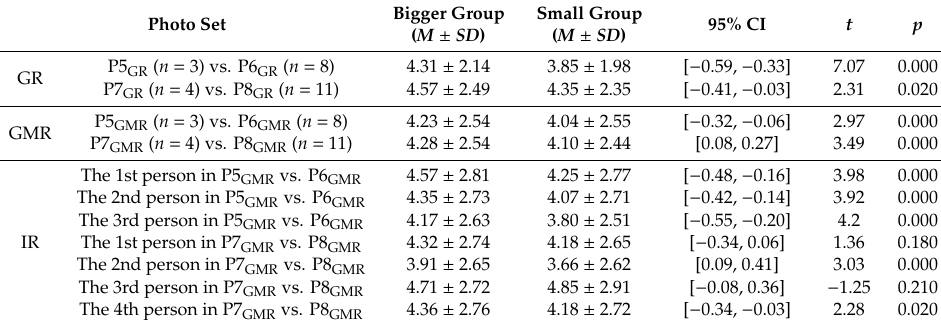
Table 7. Test of size e ff ect on GR, GMR, and IR from Study Ia ( n =